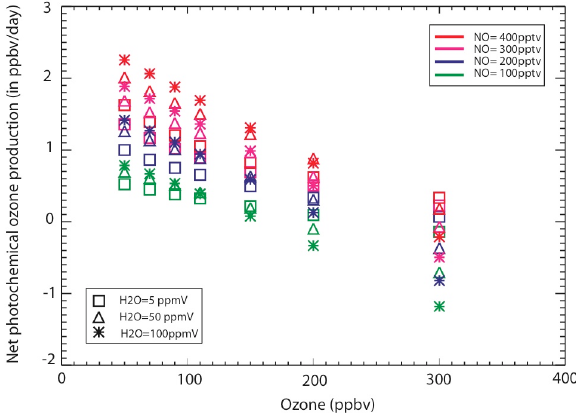
Figure 13: Net photochemical O 3 production rates (ppbv per day) versus initial ozone 3 Fig. 13. TTL net photochemical O 3 production rates (ppbv per day) concentrations (ppbv) as a function of initial H 2 O concentrations (ppmv, symbols – see inset) 4 versus initial ozone concentrations (ppbv) as a function of initial and NO concentrations (pptv, colours as indicated). Results from photochemical model 5 H 2 O concentrations (ppmv, symbols – see inset) and NO concen- simulations run for 4 days at 150 hPa and initialised with concentrations taken from aircraft 6 trations (pptv, colours as indicated). Results from photochemical observations in the upper troposphere. Net photochemical O 3 production rates are averages 7 model simulations run for 4 days at 150hPa and initialised with over the last 24h. See text for further details. 8 concentrations taken from aircraft observations in the upper tropo- sphere. Net photochemical O 3 production rates are averages over the last 24h. See text for further